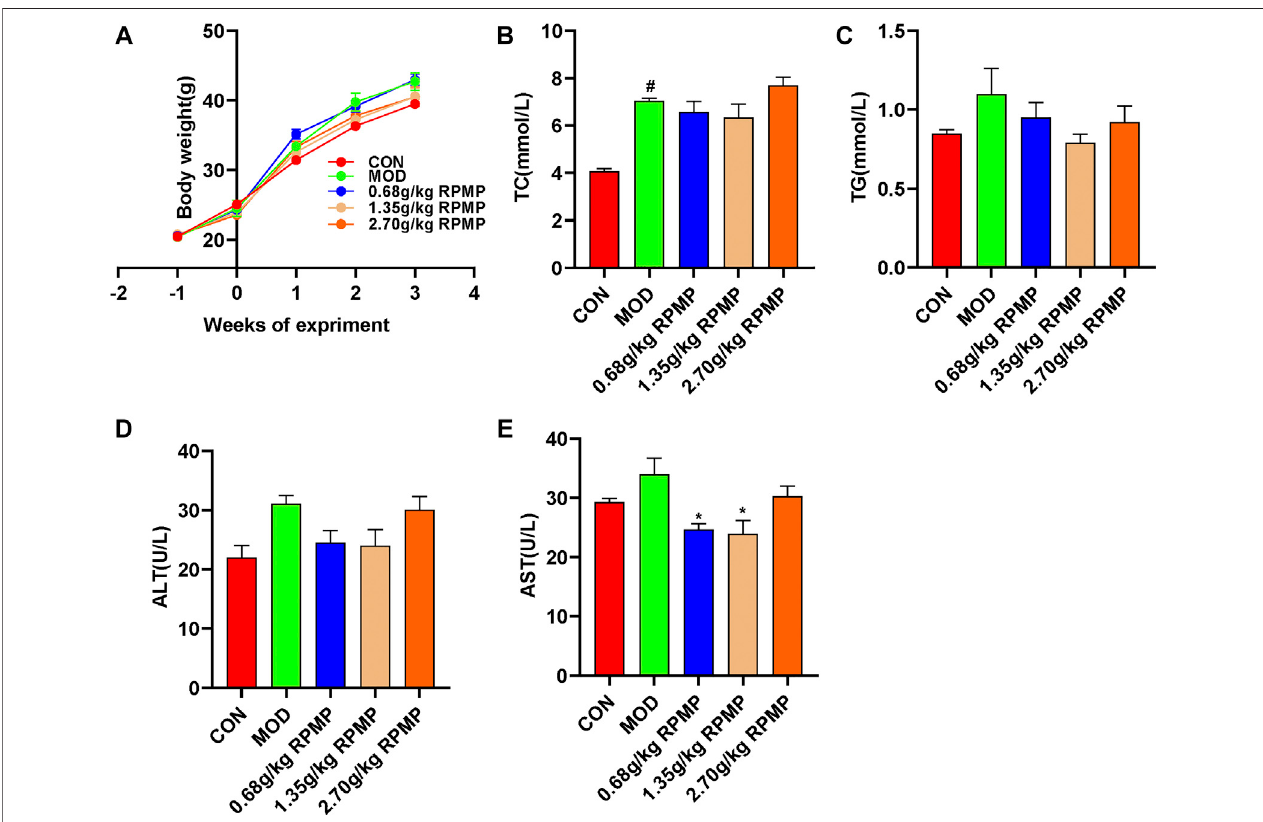
FIGURE2 | Dose assessment ofRPMP ethanol extract. (A) Trends in body weight ofmice. (B – E) Serum biochemical indices ofmice. The data were presented as the means ± SEM, # p < 0.05, compared with the CON group; * p < 0.05, compared with the MOD group ( n (cid:2) 6).